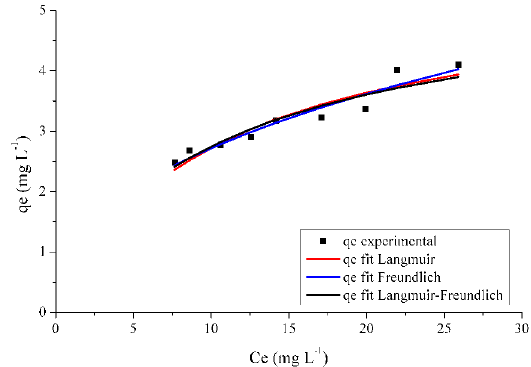
Figure 9. Experimental and predicted adsorption isotherms for tetracycline for the Langmuir, Freundlich and Langmuir-Freundlich models, at temperature of 35